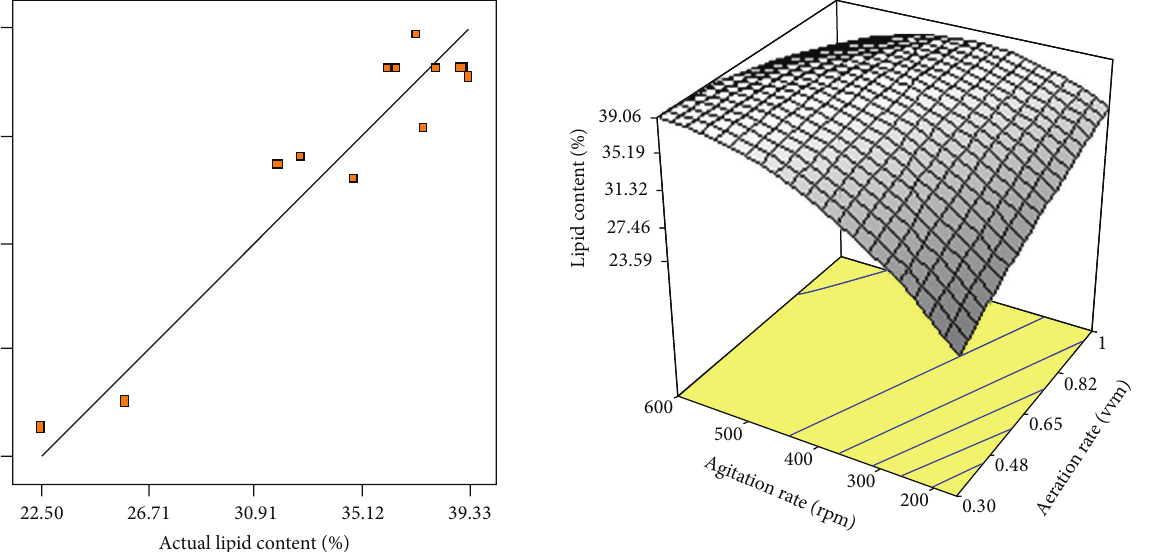
Figure 5: Experimental lipid content produced versus the predicted lipid content by the statistical model under operating conditions.